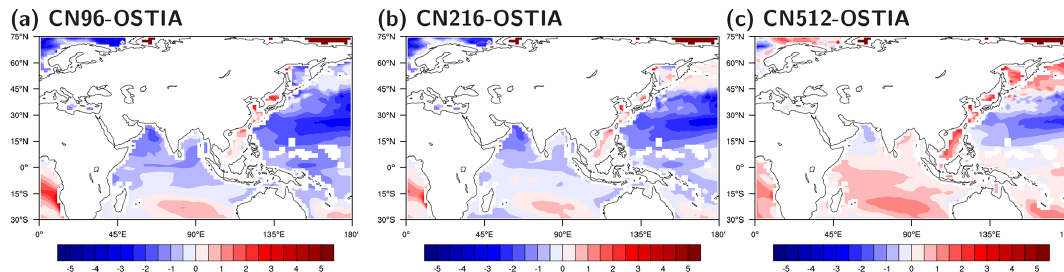
Figure 11. SST bias in MetUM coupled simulation in DJF (units: